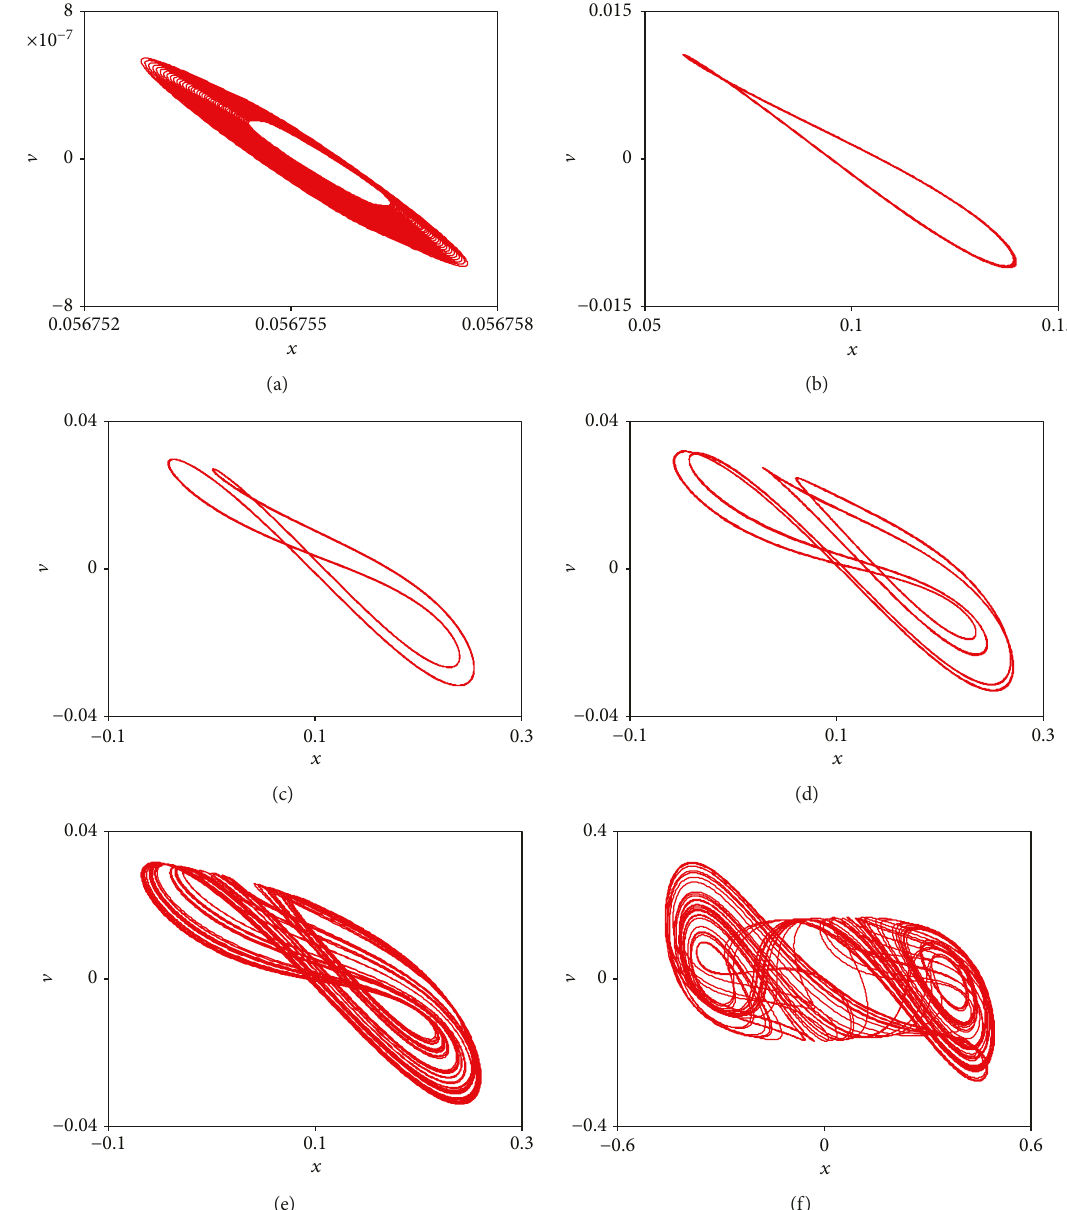
Figure 7: Phase portrait with di ff erent circuit parameter a . (a) Sink ( a = 0 015 ), (b) limit cycle ( a = 0 03 ), (c) period-2 cycle ( a = 0 043 ), (d) period-4 cycle ( a = 0 04484 ), (e) one-scroll chaotic attractor ( a = 0 05 ), and (f) two-scroll chaotic attractor ( a = 0 2